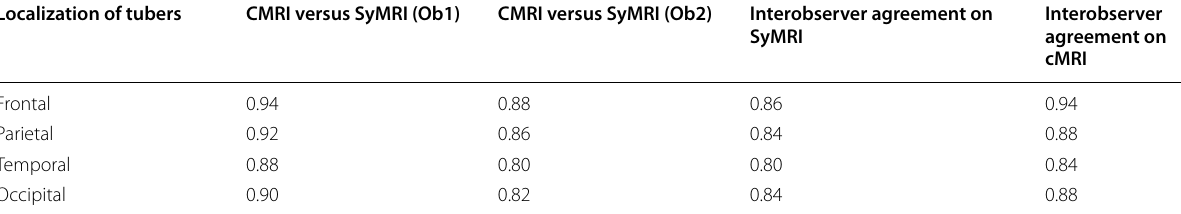
Ob: observer, vs: versus